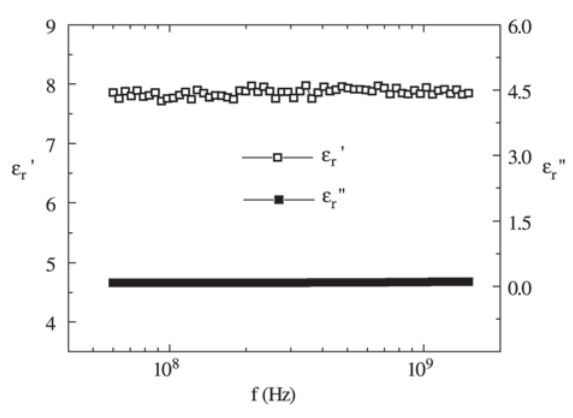
Figure 3. Dielectric response for the alumina ceramic by using the coaxial line method with the adapted moving sample holder, at room